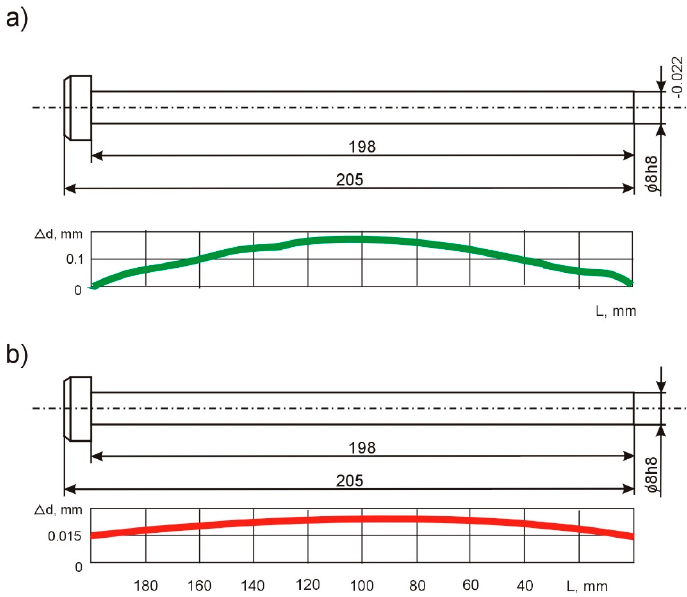
Figure 10. Longitudinal form error, Δ d , for single-pass shaft machining: ( a ) without the adapting device and ( b ) with the use of the device .